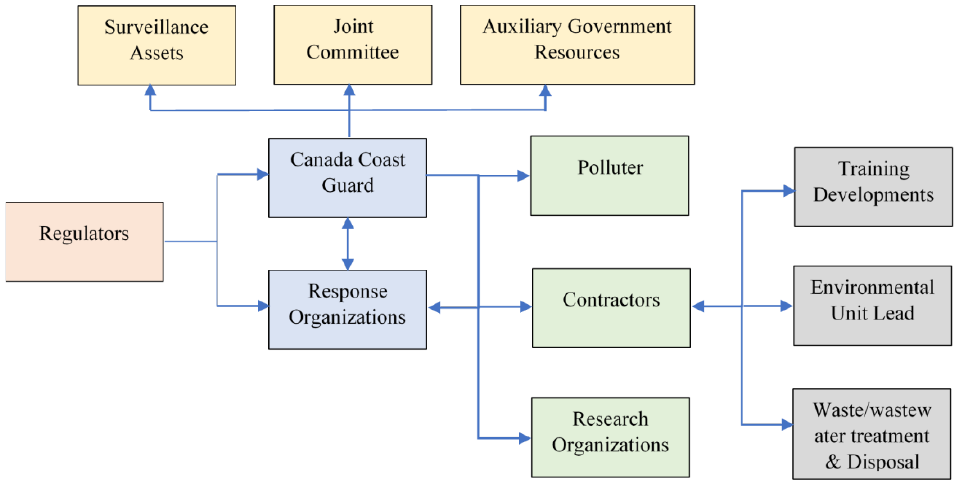
Figure 1. Canadian Oil Spill Response Network.